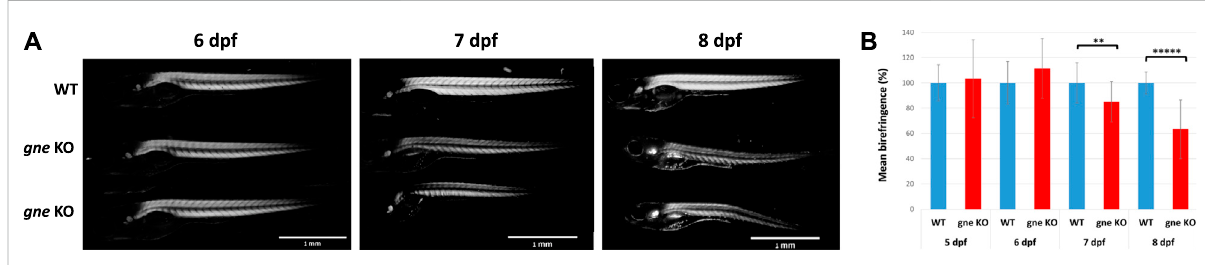
FIGURE 4 gne KO results in skeletal muscle defects which appear at 7 dpf. (A) A reduction in muscle birefringence is observed in gne KO larvae at 7 dpf, compared to WT sibling, and correlates to the severity of the phenotype at 8 dpf. (B) Quanti fi cation of the mean birefringence revealed a signi fi cant